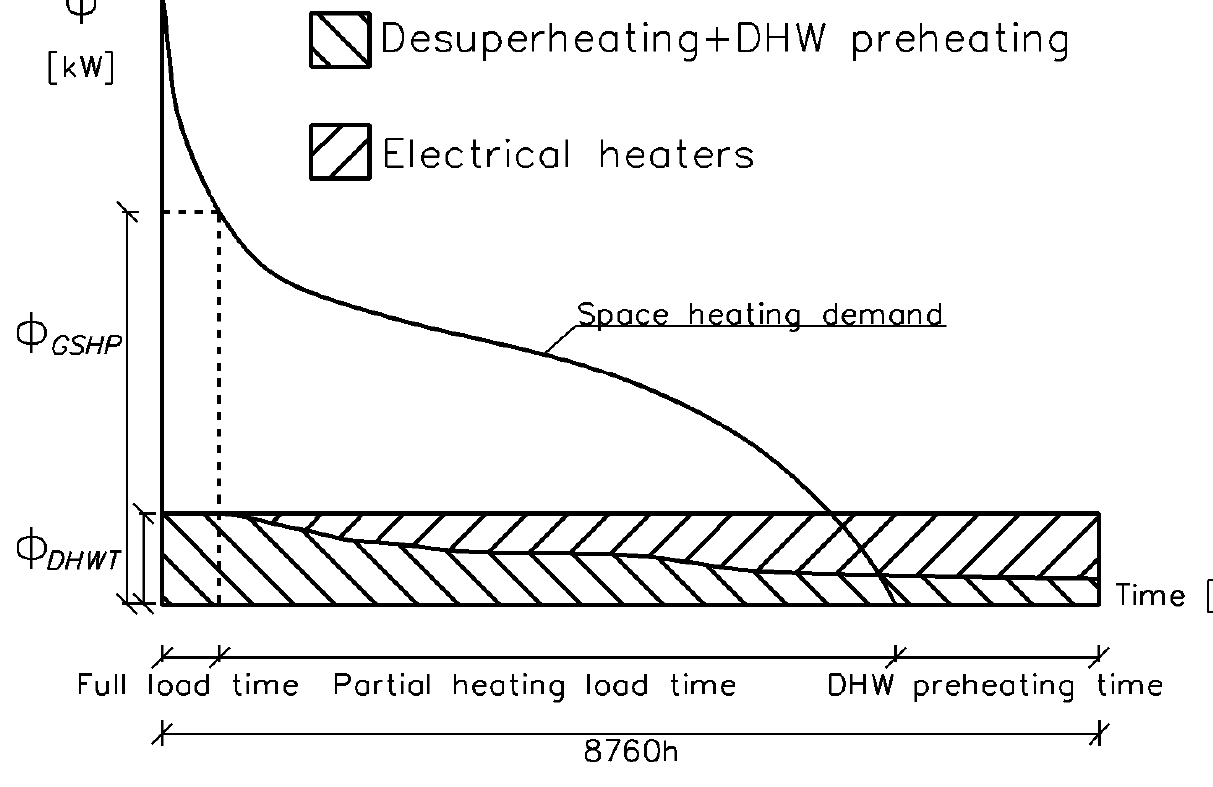
Figure 11. Exploiting possibilities of desuperheaters in DHW